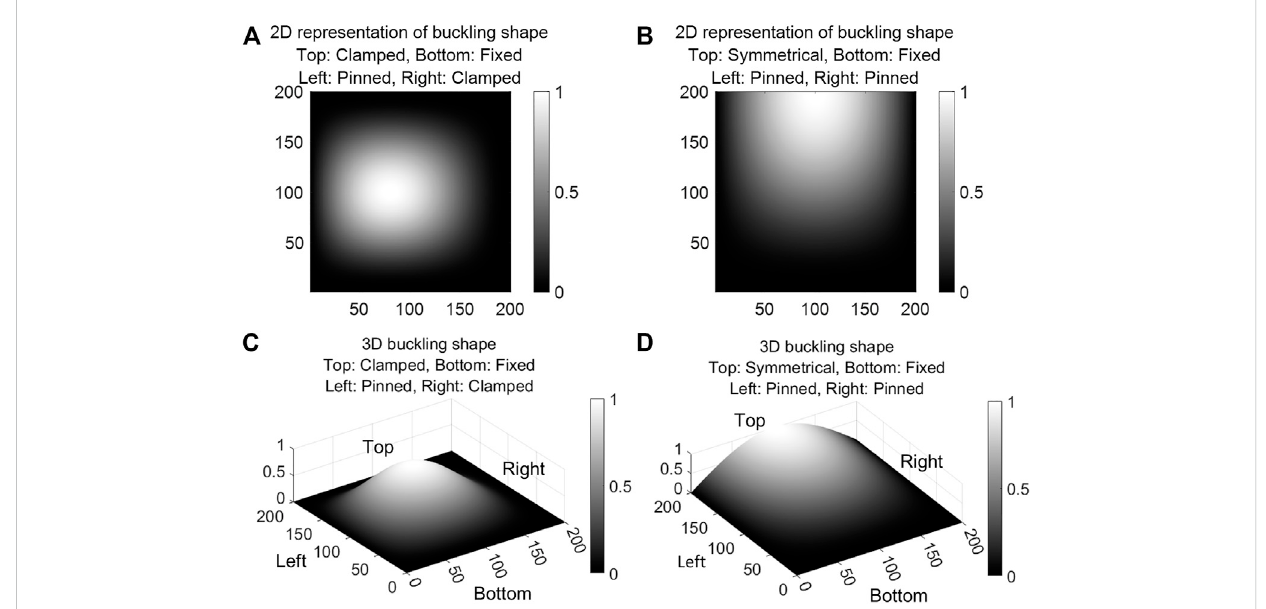
FIGURE 6 TypicalbucklingshapesoftheFEplatemodels.- (A) and (C) :2Dand3Drepresentations,respectively,ofthetheoreticalbucklingshapeofaplatewith thetopandrightedgesclamped,theleftedgepinned,andthebottomedge fi xed.- (B) and (D) :2Dand3Drepresentations,respectively,ofthetheoretical buckling shape of a plate with the top boundary condition symmetrical, the right and left edges pinned, and the bottom edge fi